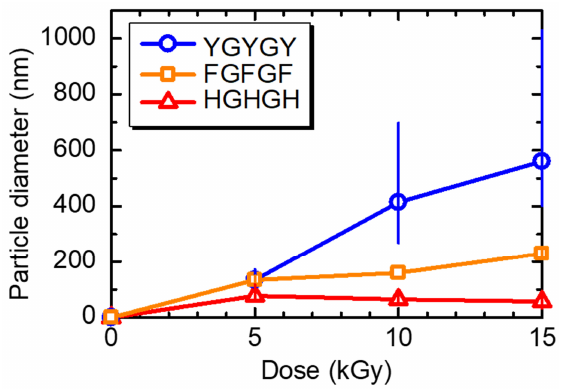
Figure 3. Dose dependence of the nanoparticle size obtained from three peptides by γ -ray irradiation. The dose dependence of the particle size appears to be different at values above and below 5 kGy. Moreover, the particle sizes of the peptides are considered to be affected by the dissolved oxygen concentration based on the bimolecular reaction of the peptide (Equation (8)). Thus, the addition of ·OH radicals to Phe and Tyr was enhanced by the dissolved oxygen [32], while their bimolecular reaction (Equation (8)) was suppressed. The concentration of dissolved oxygen is ~250 µmol dm − 3 under aerated conditions, while the radiation chemical yield (G-value) of the ·OH radicals from water radiolysis is 280 µmol dm − 3 kGy − 1 . Thus, the bimolecular reaction is more advantageous than ·OH addition and degradation of the peptide (Equation (4)) above 1 kGy when the dissolved oxygen is completely reacted with the peptide and consumed. 3.4. Stability and Biodegradability of the Peptide Nanoparticles The particle size stabilities of the nanoparticles were investigated by DLS in water and in PBS to simulate in vivo conditions (Figure 4). The FGFGF nanoparticles in both water and PBS broke down after one day. The YGYGY nanoparticles in PBS lasted for two days before they began to degrade and no particles were observed on the third day. The YGYGY particles in water were observed for a few days; however, decomposition and aggregation eventually occurred and no particles were observed on the fifth day. Both the FGFGF and YGYGY nanoparticles were considered to be decomposed by the dissolved oxygen because Phe and Tyr residues are easily oxidized by dissolved oxygen. On the other hand, the HGHGH nanoparticles were stable in water and PBS for six days because